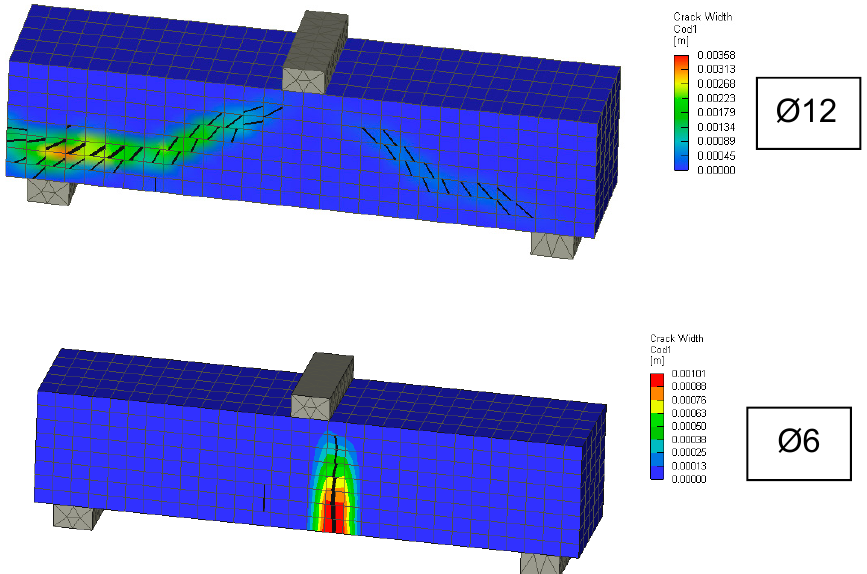
Figure 11. Small RC beams without transverse reinforcement, showing a 3D numerical model with a crack (min. 0.2 mm).